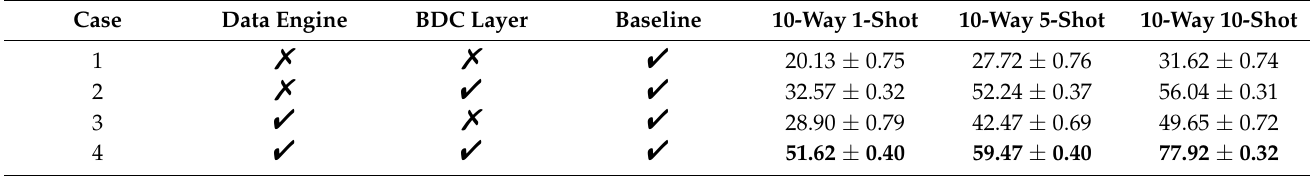
Table 1. Results of ablation